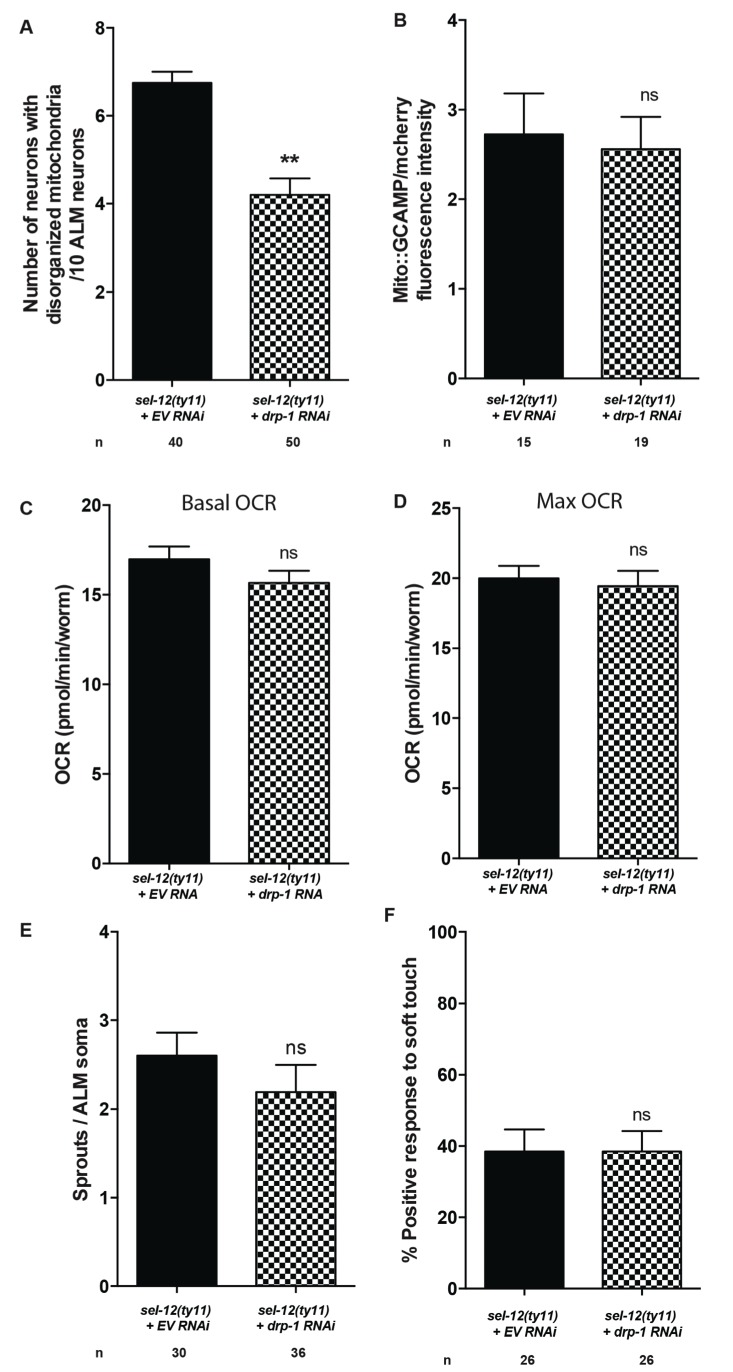
Reduction of mitochondrial fission does not alleviate the neurodegeneration in sel-12(ty11) animals.(A) Quantification of ALM neuronal mitochondrial morphology in sel-12(ty11) animals grown on EV and drp-1(RNAi). Analysis was done using transgenic animals expressing mito::GFP in mechanosensory neurons (jsIs609). (B) Quantification of mitochondrial Ca2+ using animals expressing mito::GCaMP6 and mCherry in their mechanosensory neurons (takEx415). (C) Basal and (D) maximal respiration rates of sel-12 mutant animals grown on EV and drp-1(RNAi). (E) Quantification of aberrant structures (sprouts/branches) on ALM neuronal soma of sel-12(ty11) animals grown on EV and drp-1(RNAi). (F) Response of day one sel-12(ty11) animals grown on EV and drp-1(RNAi) to light touch. n = number of animals analyzed per genotype. Data are displayed as mean ± SEM, and all comparisons have been made to wild type animals unless otherwise indicated. ns p>0.05, **p<0.001 (two-tailed T-test).10.7554/eLife.33052.034Figure 8—figure supplement 1—source data 1.Raw data for Figure 8—figure supplement 1.